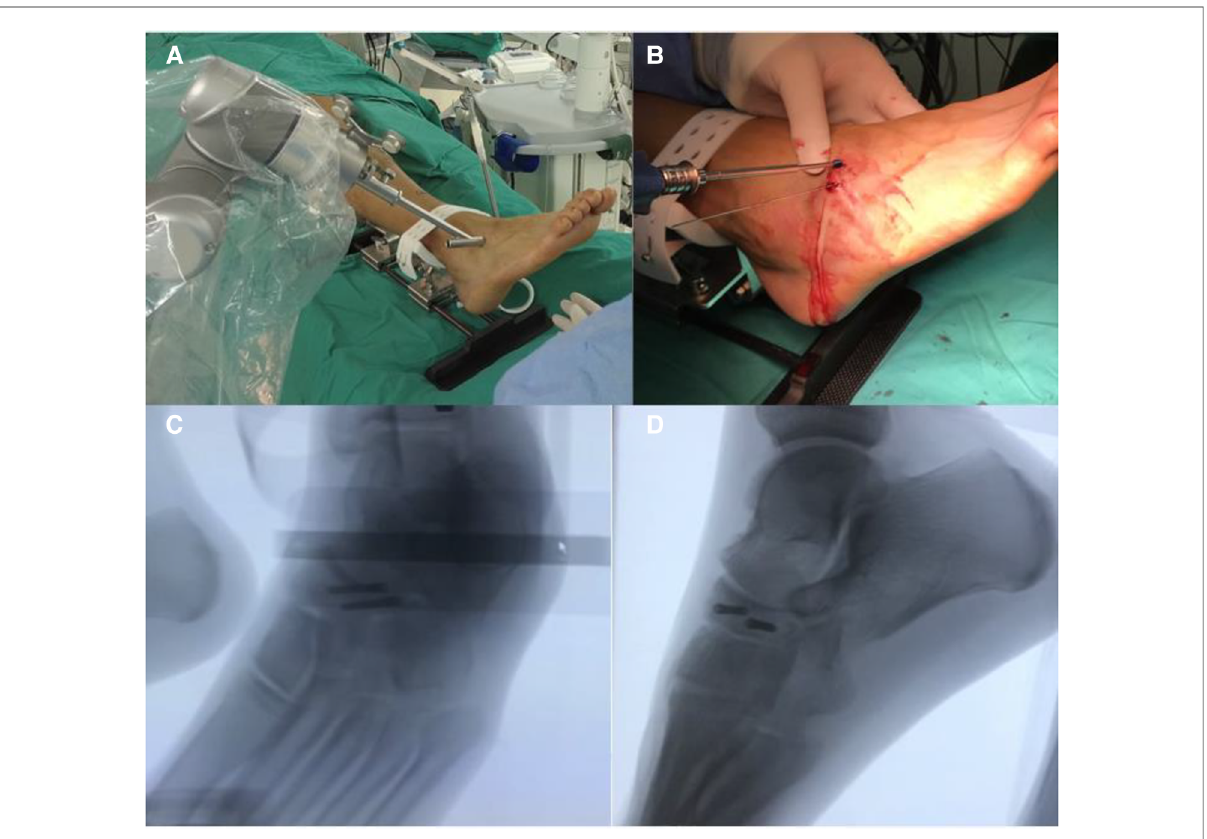
FIGURE 4 Intraoperative operation assisted by TINAVI intelligent orthopedic robot. ( A ) Intraoperative navigation assisted positioning by robot; ( B ) internal screw fi xation via Kirschner wire prepositioning; ( C ) front view of the right foot of Artis zeego; ( D ) lateral view of the right foot of Artis